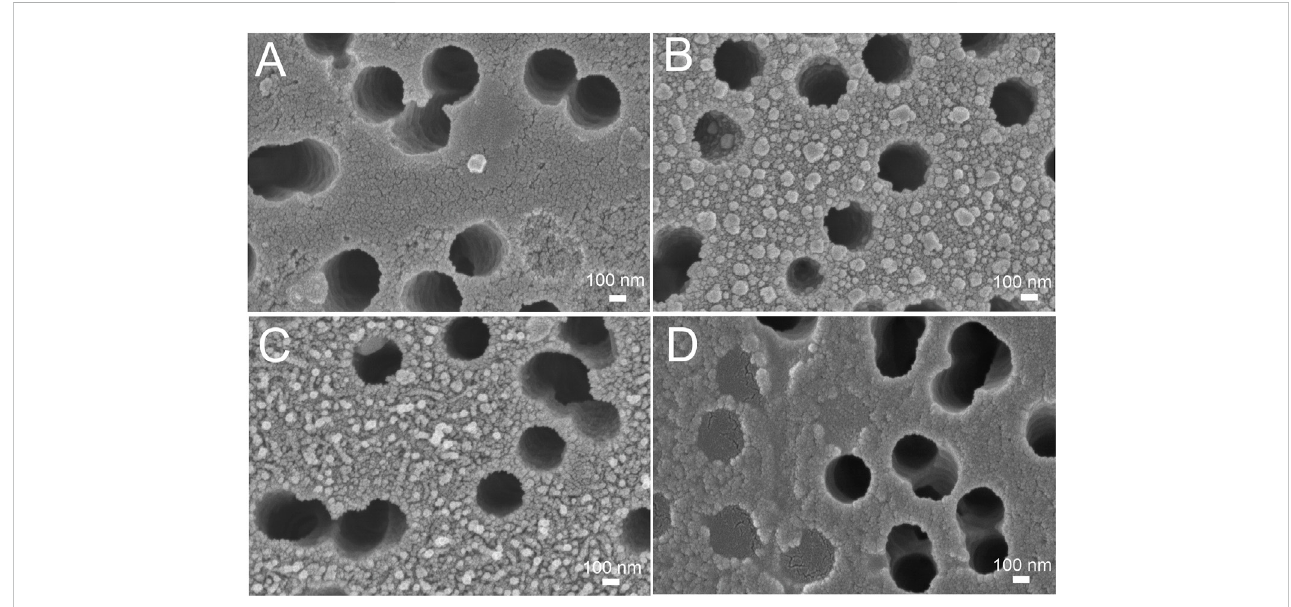
Scanningelectronmicroscopyofthetrack-etchedmembranesfunctionalizedwiththeaptamerafterthe fi ltrationofphosphate-bufferedsaline (A) ,3 · 10 8 VP/mL of in fl uenza A virus (B) , 2 · 10 6 VP/mL of in fl uenza A virus (C) , and 30 VP/mL of in fl uenza A virus (D) .